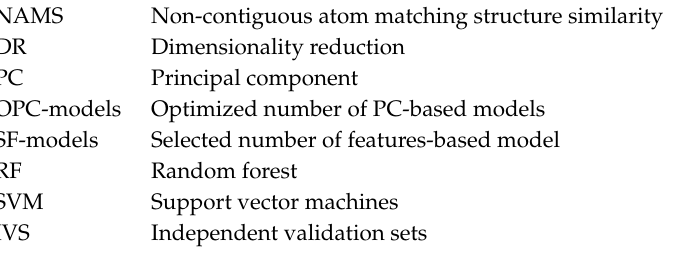
three supplementary tables including: Table S1: List of RDkit 2D and 3D descriptors, Table S2: 5-fold cross-validation results, Table S3: External validation results, Figure S1: Selection of optimized number of PCs: PVE vs. number of PCs plot from PCA on metric